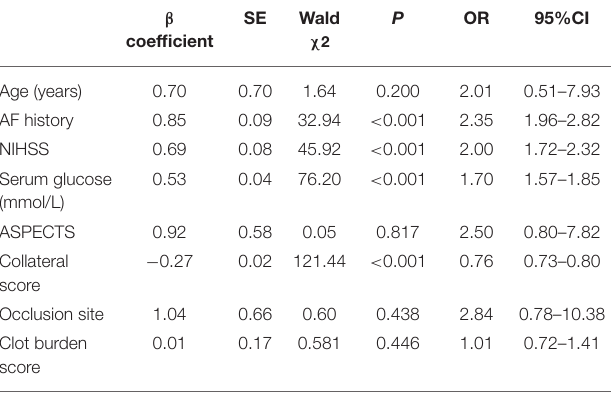
TABLE 3 | Multivariate logistic regression analysis of risk factors for HT.